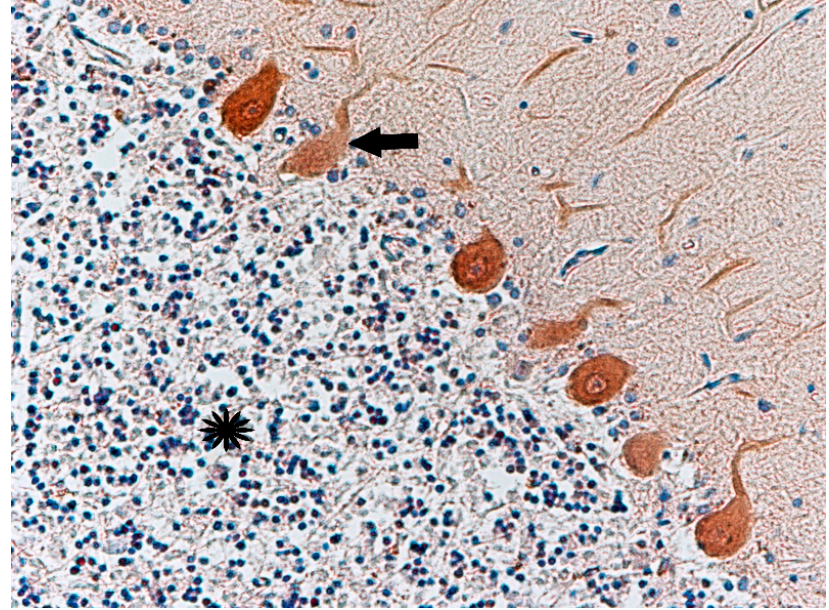
Figure 9. Case no. 2 Cerebellar cortex. Slightly attenuated immunohistochemical reaction with calbindin-D-28k antibody in Purkinje cells (arrow). Slightly thinned neurons in the granular layer (asterisk). Magnification 200 × .